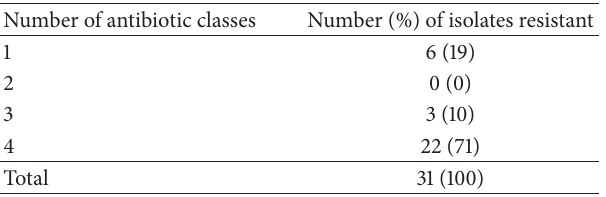
Table 5: Number of antibiotic classes to which isolates were